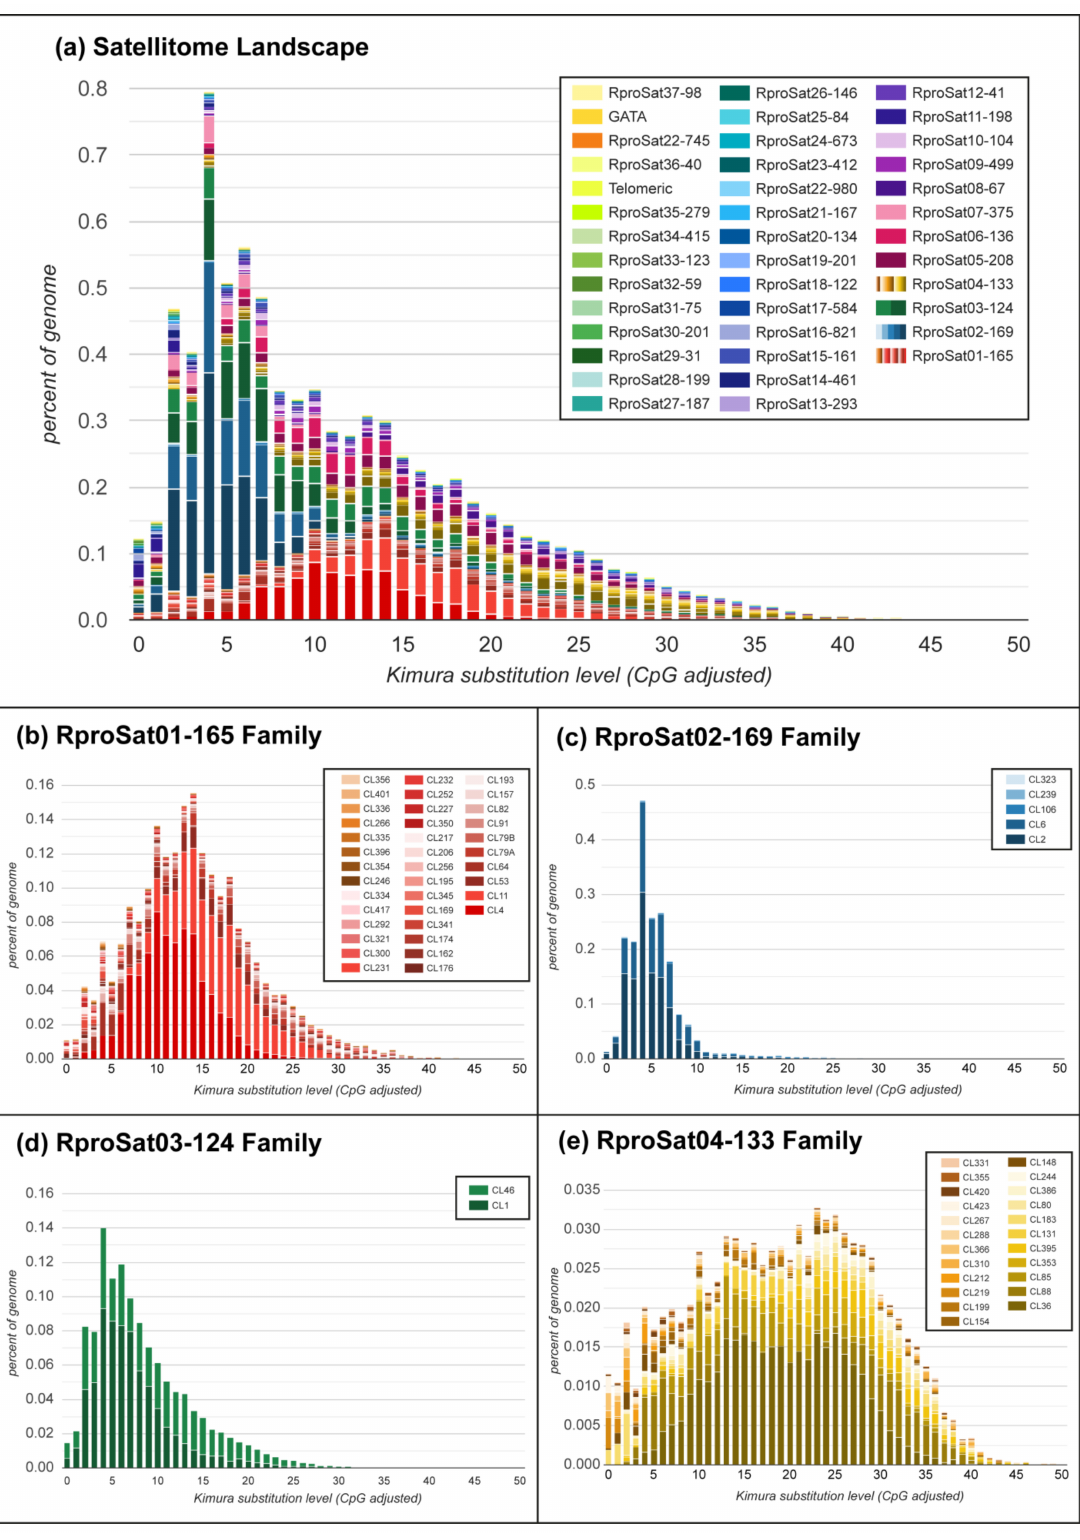
Figure 2. ( a ) Satellitome landscape of the satDNA families in Rhodnius prolixus . In the landscape, abundance vs. Kimura divergence from satDNA consensus sequences is plotted. ( b – e ) Landscape of most abundant satDNA families divided by their subfamilies. The order of satDNA families and subfamilies are in order of their position on a stacked